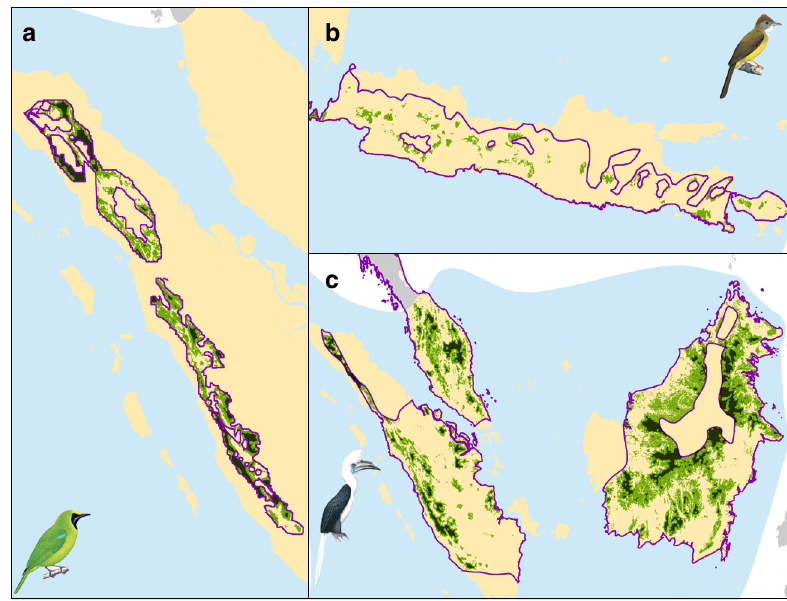
Fig. 2 Illustration of the mapping methodologies showing the impacts of habitat loss and hunting. The three panels illustrate the ranges accessible to trappers for three species in our analysis: a Sumatran Leafbird ( Chloropsis media) , b Melodious Bulbul ( Alophoixus bres ) and c White-crowned Hornbill ( Berenicornis comatus ). The purple line is the outline of the species ’ historic range (as provided by BirdLife International). The green area, which is divided into two shades, indicates the total extent of suitable habitat for the species in 2015, once it has been re fi ned for current forest extent and elevation. The dark green regions are areas that are further than 5 km from the forest edge and considered inaccessible to trappers; the light green areas are regions that are within 5 km of a forest edge where exploitation is likely taking place. Species illustrations are not within the CC-BY license of this publication, and instead are reproduced from del Hoyo, J., Elliott, A., Sargatal, J., Christie, D.A. & de Juana, E. (eds.) (2018). Handbook of the Birds of the World Alive. Lynx